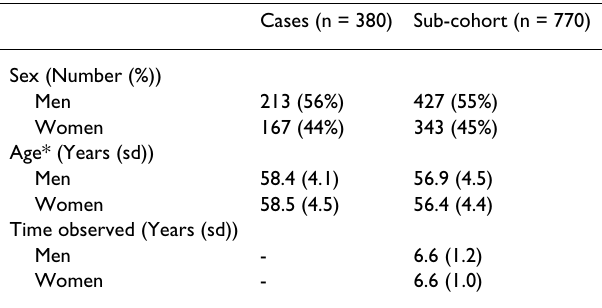
Table 1: Characteristics of the cohort Cases (n = 380) Sub-cohort (n = 770) Sex (Number